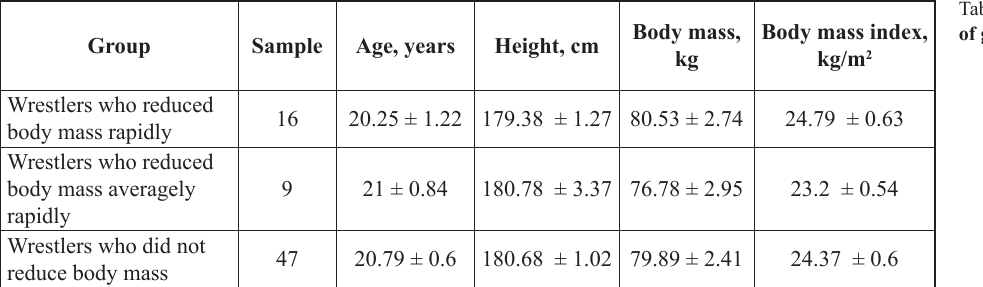
Table. Characteristics of